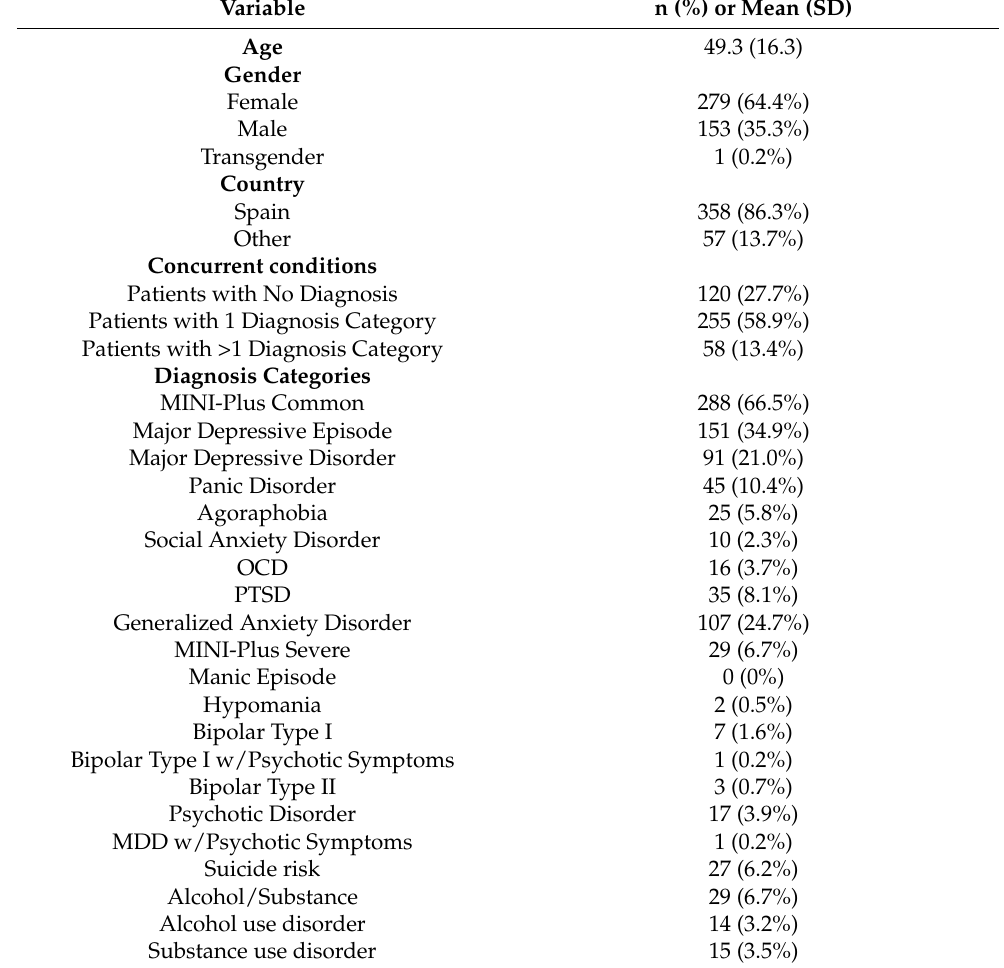
Table 2. Descriptive characteristics of participants (n =